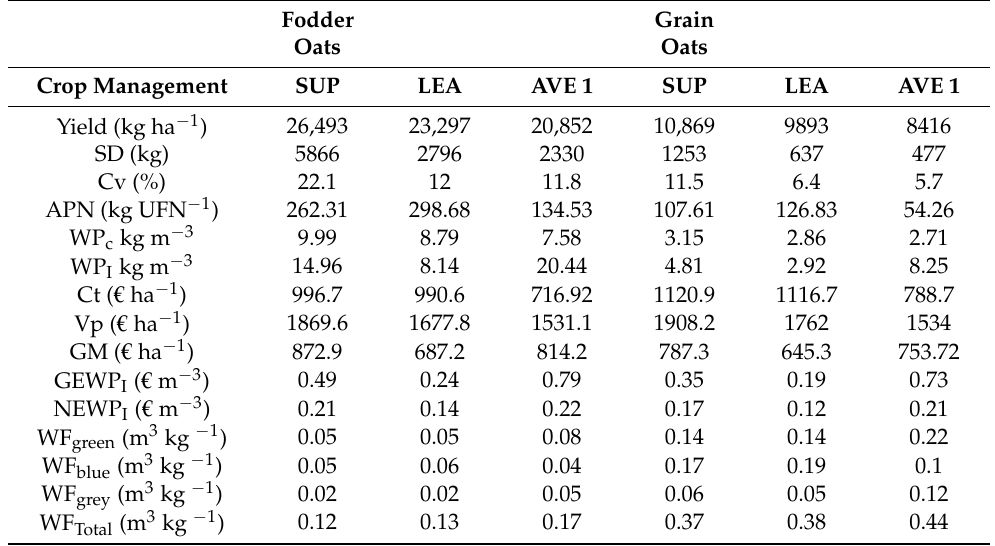
Table 8. Yield and water productivity in the different managements of fodder and grain oats.